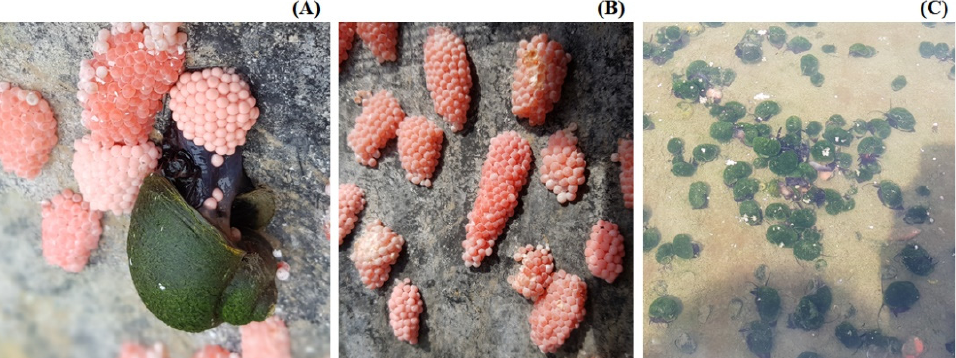
Figure 3. ( A ) Snail in the process of laying eggs; ( B ) cluster of eggs attached to the pen wall surface above water level; ( C ) mature snails in the pen.